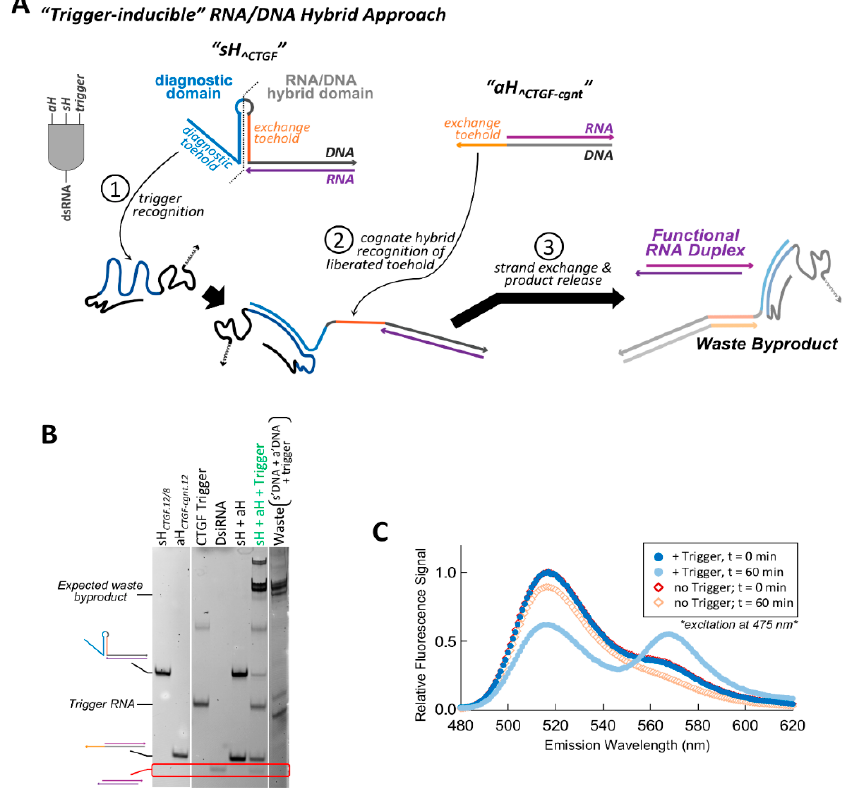
Figure 3. Incorporation of a structured responsive element can generate a trigger-inducible RNA/DNA hybrid system. ( A ) The inducible hybrid system functions as a three-input AND gate. The sense hybrid sH ^CTGF.12/8 contains a responsive DNA hairpin composed of a 12 bp stem and an 8 nt loop, and is flanked by an extended 5 ′ single strand that acts as a diagnostic toehold. Trigger hybridization to the diagnostic toehold progresses through the hairpin stem and unzips the hairpin (sequence regions colored blue). This liberates a previously sequestered toehold within sH ^CTGF.12/8 which can then hybridize with the complementary toehold of the cognate antisense hybrid, aH ^CTGF-cgnt.12 . Hybridization of these exchange toeholds (sequence regions colored orange) initiates strand exchange and releases a dsRNA product. ( B ) The function of this conditional system was assessed by 8% acrylamide non-denaturing PAGE and total staining with ethidium bromide. DsiRNA release is observed when the sense and antisense hybrids are co-incubated in the presence of trigger (red box). Formation of the expected waste product is observed by comparison to a control assembly of the s’ and a’ DNA strands with the trigger molecule. All samples were incubated for 30 min at 37 °C. ( C ) F ö rster resonance energy transfer (FRET) analysis was performed as another method to verify conditional dsRNA formation. sH ^CTGF.12/8 was assembled using a 3 ′ 6-carboxyfluorescein (6-FAM) (ex/em 495/520 nm) labeled sense RNA strand. aH ^CTGF-cgnt.12 was assembled using a 5 ′ -AlexaFluor546 (ex/em 555/570 nm) labeled antisense RNA strand. The hybrids were mixed and incubated at 37 °C